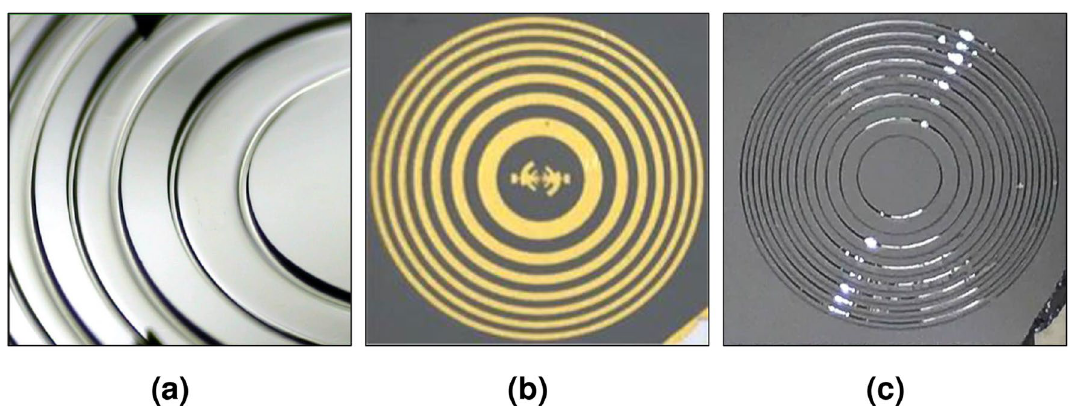
Figure 6. The optical image of the fabricated lens-antenna device: ( a ) a microscopic image of the edged FZP. ( b ) Log-periodic antenna side. ( c ) The FZP’s